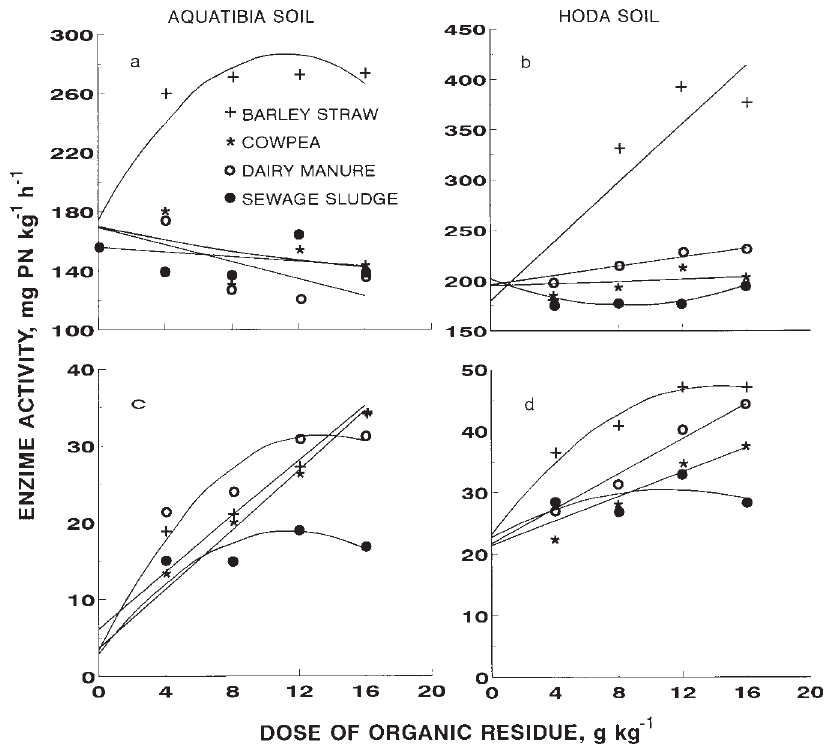
plantsFigure 2. Amounts of p -nitrophenol (PN) released by the activity of soil acid phosphatase (a and b) and soil phosphodiesterase (c and d), in two soils previously treated with increasing amounts of organic residues and